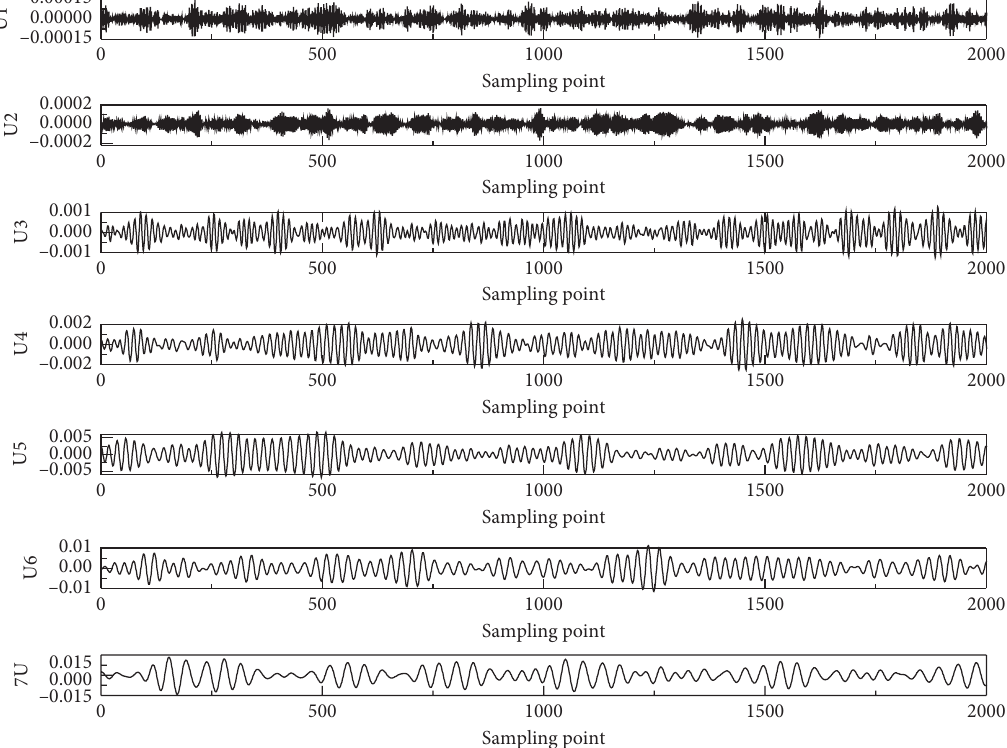
Figure 6: The components of VMD decomposes the upstream pipeline leakage original signal of the no. 1 sensor.